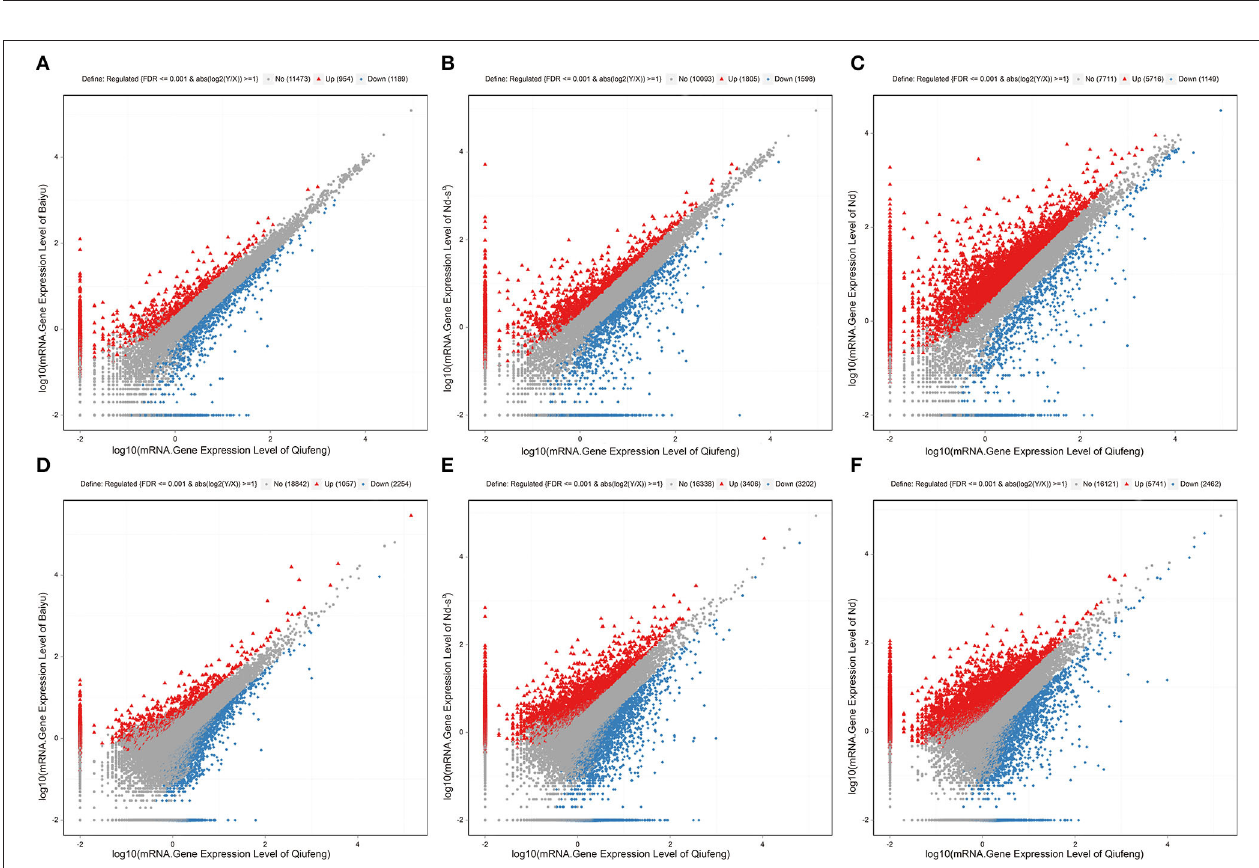
FIGURE 3 | Scatter plot of mRNA and lncRNA expression levels. mRNA gene expression levels in Qiufeng vs. Baiyu (A) , Qiufeng vs. Nd-s D (B) and Qiufeng vs. Nd (C) . LncRNA gene expression levels in Qiufeng vs. Baiyu (D) , Qiufeng vs. Nd-s D (E) and Qiufeng vs. Nd (F) . The red points represent upregulated DELs, the blue points represent downregulated DELs, and the gray points represent genes that were not significantly different between strains.